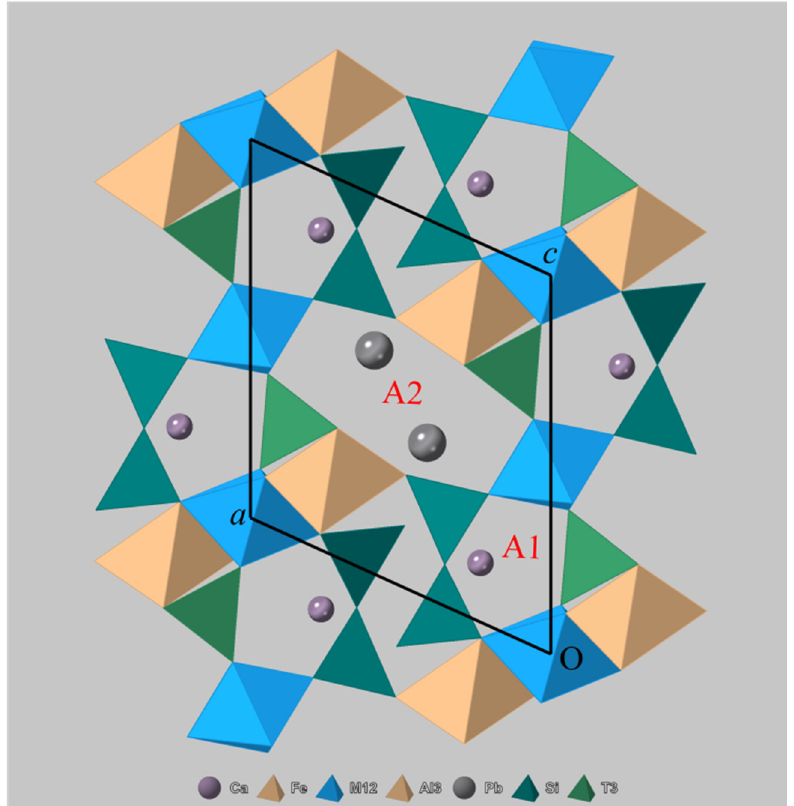
Figure 9. Crystal structure of hancockite as seen along b . The mineral is isotypic with P 2 1 / m epidotes, with chains of M1 octahedra with laterally linked distorted M3 octahedra, and chains of M2 octahedra, both running along b . Octahedral chains are interconnected along a and c directions through corner sharing disilicate groups and isolated T3 tetrahedra, respectively.